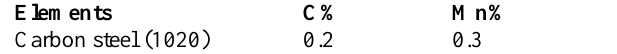
Workpiece Material Composition (Carbon Steel 1020) .